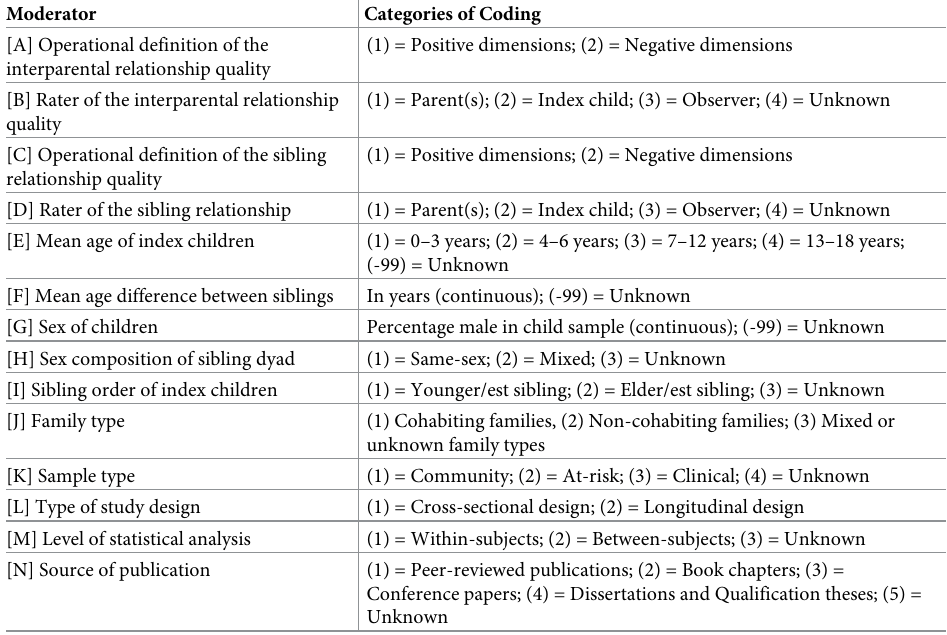
Table 1. Coding scheme of